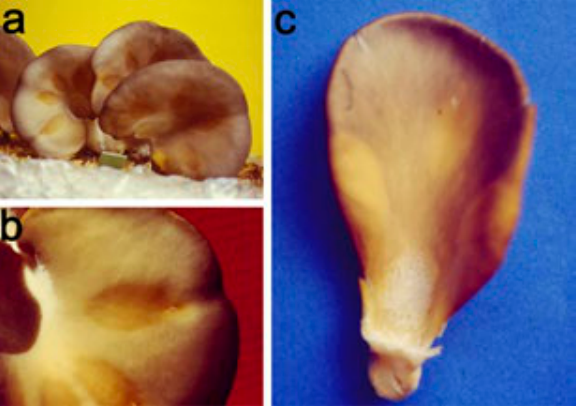
Figure 4. Pathogenicity assays on Pleurotus ostreatus whole sporocarps syringe-injected with bacterial suspensions. Yellow-brown sunken lesions surrounded by yellowish ar- eas (a and b) and yellow superficial lesions (c) on caps of P. ostreatus sporocarps syringe-injected with 10 8 cfu mL -1 bac- terial suspensions of strains USB1, USB22 and NCPPB2192 of Pseudomonas tolaasii (a and b) and of strains USB6, USB20 and NCPPB1311 of P. ‘reactans’